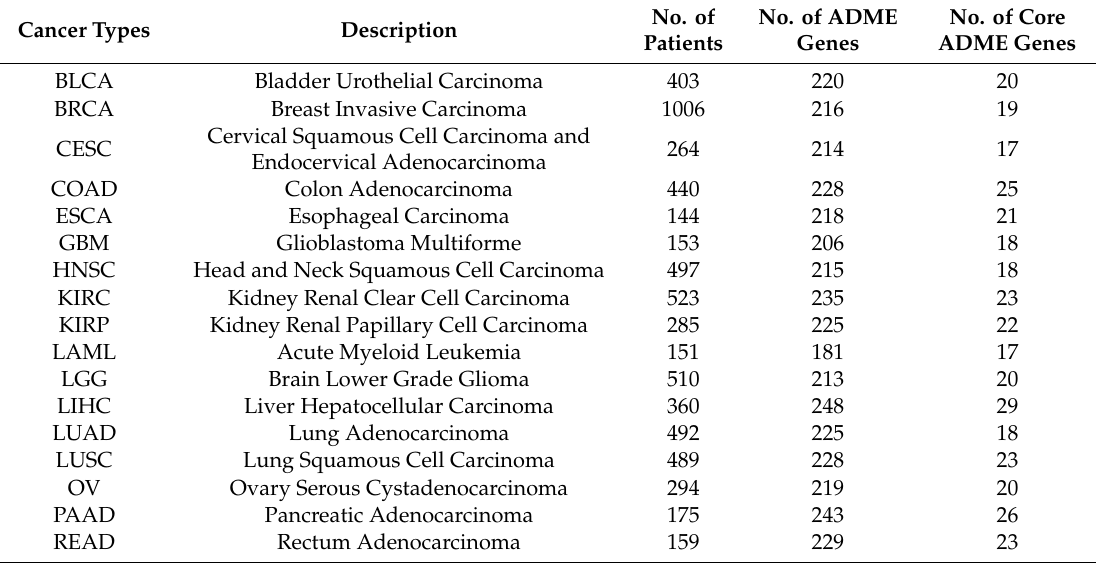
Table 1. This table lists the number of patients analysed, the number of ADME (absorption, distribution, metabolism, and excretion) genes and core ADME genes expressed for each of 21 TCGA cancer